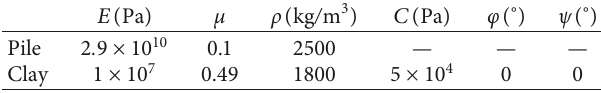
Table 1: Soil and pile properties for verification.